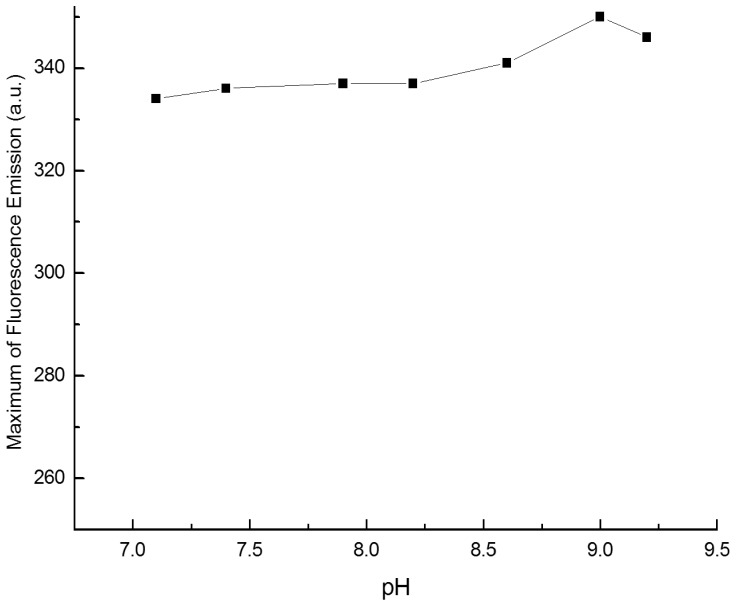
Influence of pH on the fluorescent intensity of the complex C = 2.00 µg/mL, C β-CD = 1.00×10−3 mol/L, λex/λem  =  431/540 nm.